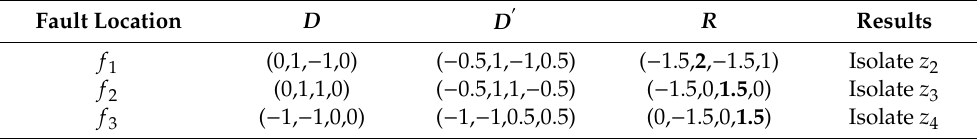
Table 6. Pole-to-ground fault simulation results for centralized pilot protection.